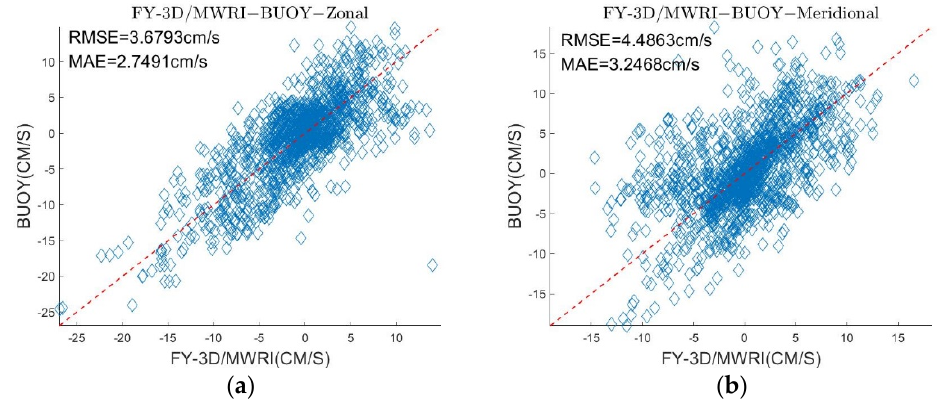
Figure 8. ( a ) is a comparison of the motions of sea ice retrieved by FY ‐ 3D/MWRI T b data merging different polarizations and frequencies with the motion of the buoy in the zonal direction, ( b ) is a comparison of the motions of sea ice retrieved by FY ‐ 3D/MWRI T b data merging different polarizations and frequencies with the motion of the buoy in the meridional direction.